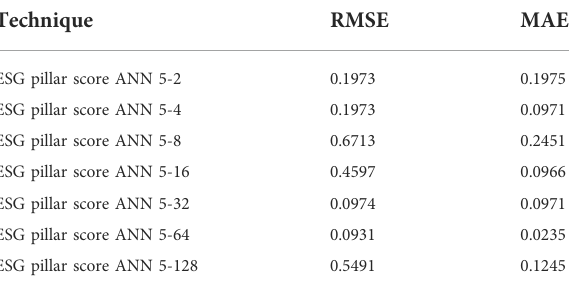
TABLE 8 Result of ESG pillar score error measurement using hidden layer 5 with 2, 4, 8, 16, 32, 64, and 128 neurons. Technique